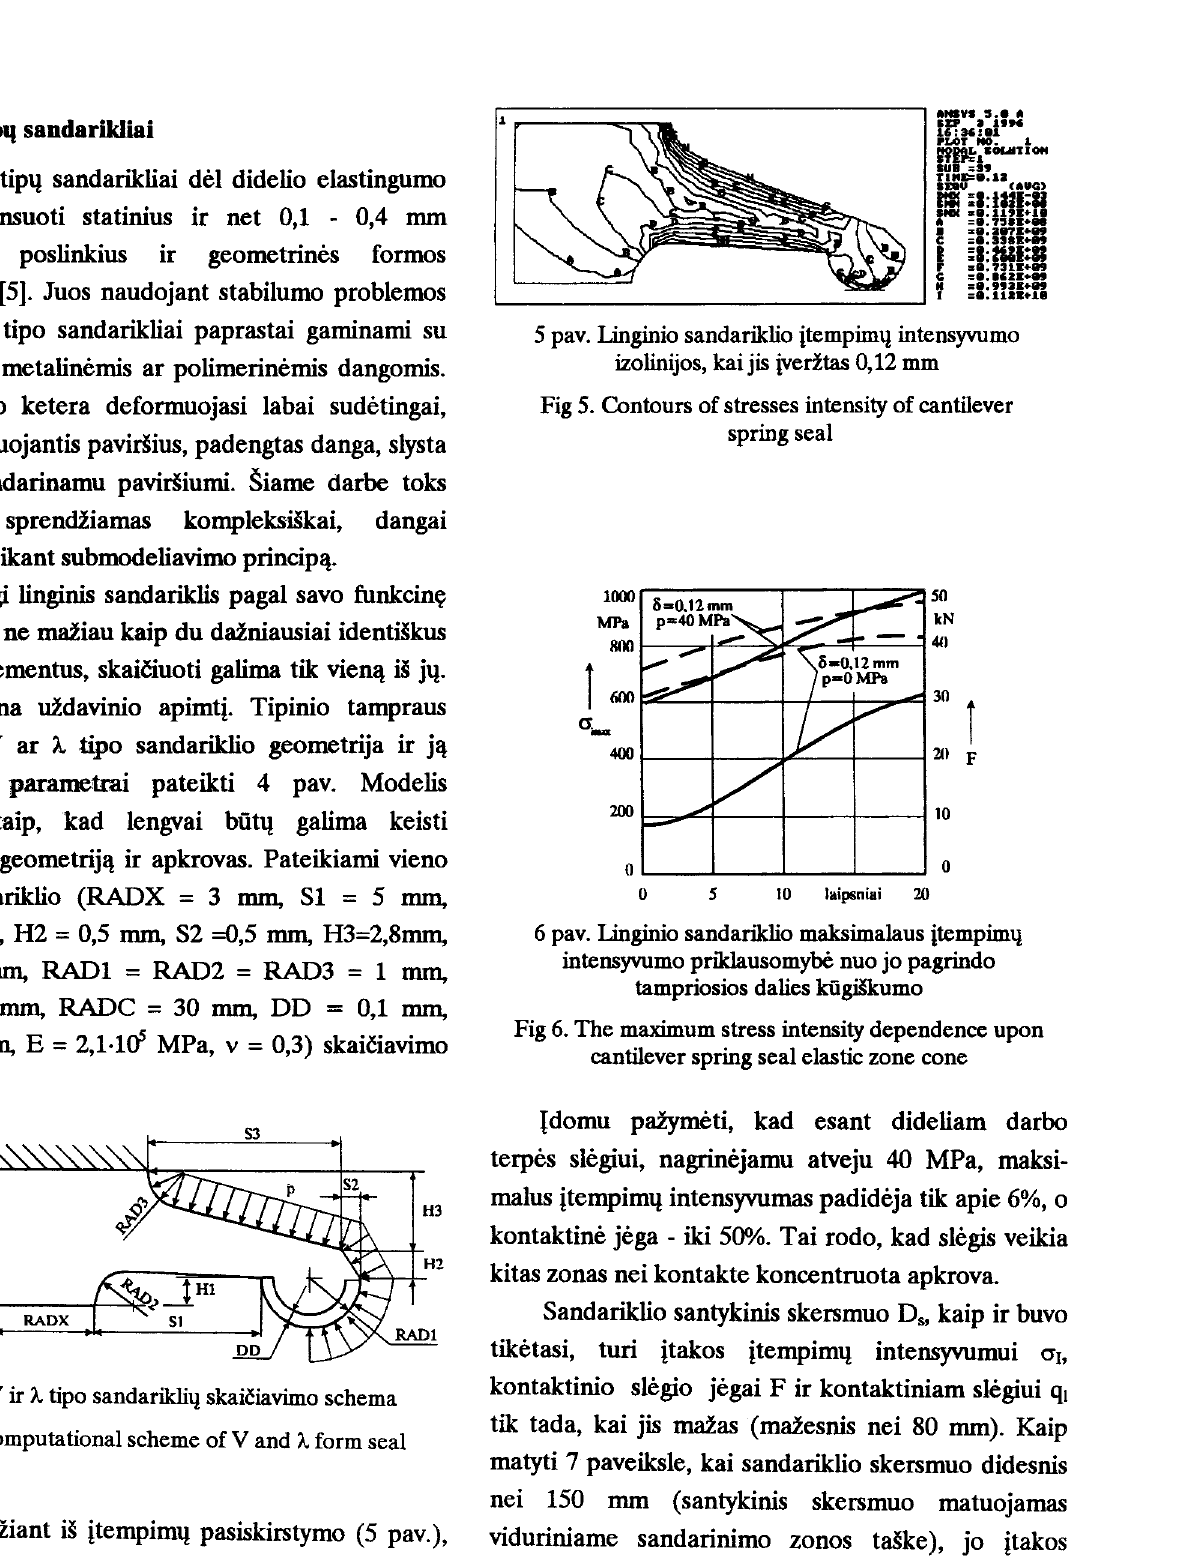
SprendZiant is itempimq pasiskirstymo (5 pav.), tampraus elemento forma ir matmenys yra parinkti racionatiai, nes nera ryskios itempimq koncentracijos skerspjiivio perejimo zonose. Siekiant ji dar pagerinti, tinges kiigiSkum~t, kuris siuo atveju sudaro 16°, deretq siek tiek padidinti, tada biitq gatima priarteti prie beveik tolygaus itempimq pasiskirstymo paviliiniuose kevalo sluoksniuose (6 pav.).